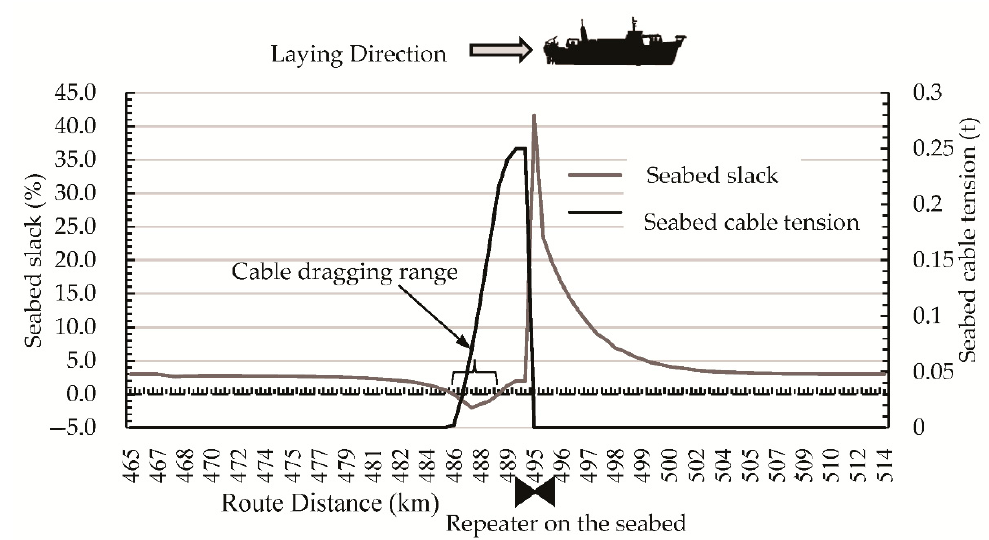
Figure 12. Details of seabed slack and seabed cable tension changes by simulation before and after the repeater reaches the seabed.